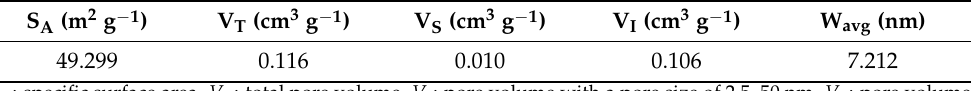
Table 2. Pore properties of CNFs@Ni(OH) 2